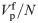
Data summary.(a) The mean deliberation time versus the fraction of jurors voting for the plaintiff. (b) The mean deliberation time versus the trial time across several datasets. (c) The distribution of the fraction of jurors voting for the plaintiff in the final vote, Vpf/N, and (d) the complementary cumulative distribution of deliberation. Error bars represent 90% confidence intervals in the mean.